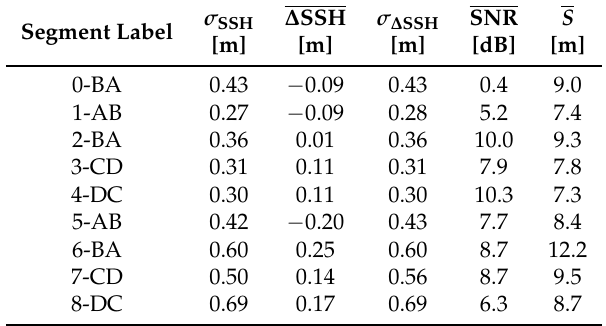
Table 5. Altimetric results for Galileo PRN11 with an integration time of 10 ms (coherent) and 10 s (incoherent).